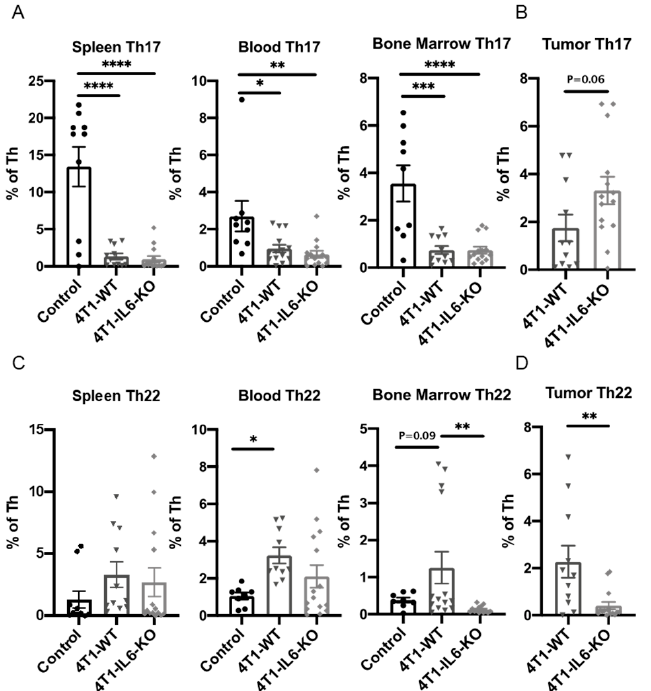
Figure 9. Knocking out tumor cell IL-6 production significantly alters type 3 T helper cell recruitment in the tumor and peripheral tissues. Tumors and peripheral tissues harvested 28 d after engraftment of 4T1-WT and 4T1-IL6-KO cell lines were analyzed for proportions of ( A , B ) T h 17 and ( C , D ) T h 22 type 3 T h cells. Healthy, non-tumor bearing mice were analyzed for comparison (Control); see Figure 2 for gating strategy. Statistical significance was measured using one-way ANOVA with Tukey’s multiple comparisons or Student’s t-test. Data are presented as mean ± SEM with n = 4–11 mice/group. * p < 0.05, ** p < 0.01, *** p < 0.001 and **** p <